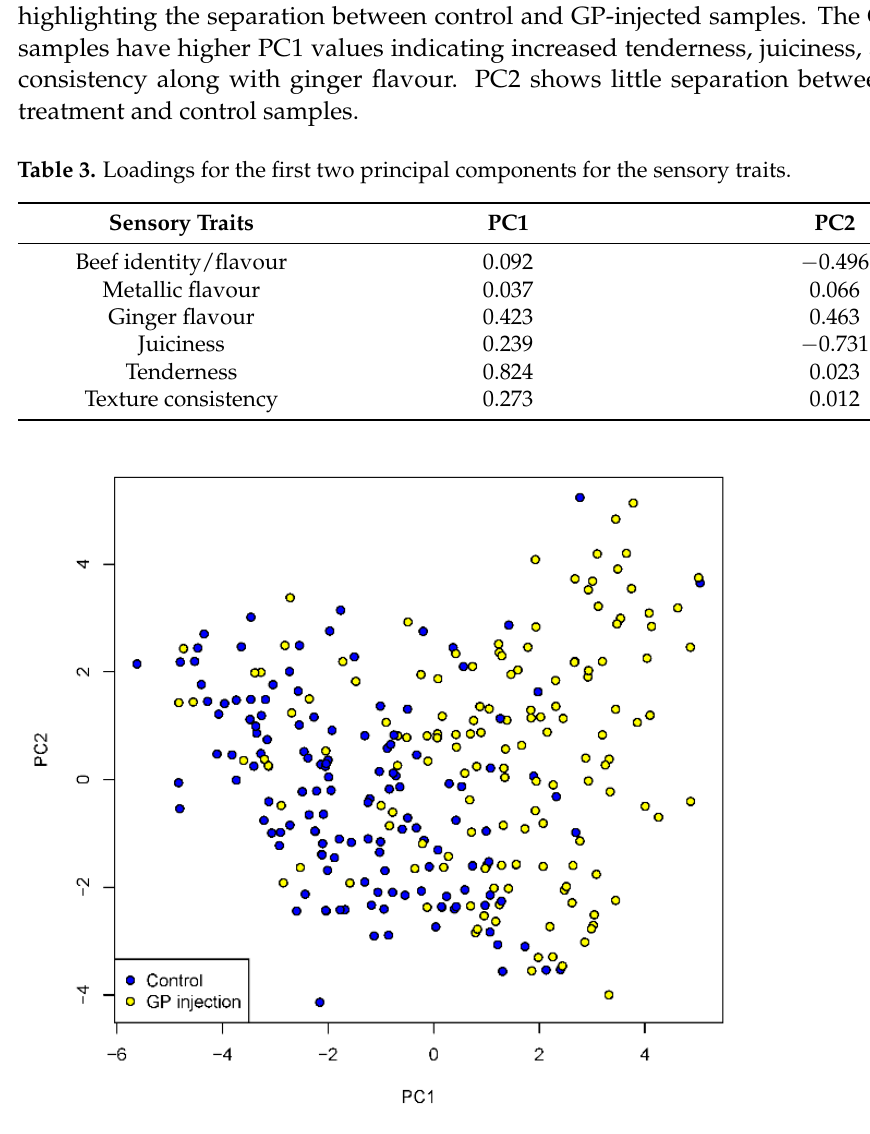
Figure 3. Scatter plot of principal component analysis (PCA), PC1 vs PC2 scores for sensory traits (beef flavour/identity, metallic flavour, ginger flavour, tenderness, juiciness, and texture consistency) of M. biceps femoris after injection treatment (GP injection = ginger powder injection containing zingibain and control = without injection), cooked at 65 °C for 8 h and 12 h under sous vide conditions. PCA separation was on injection treatment: yellow dots = injected samples; blue dots = control samples displayed in the plot. Table 3. Loadings for the first two principal components for the sensory traits.